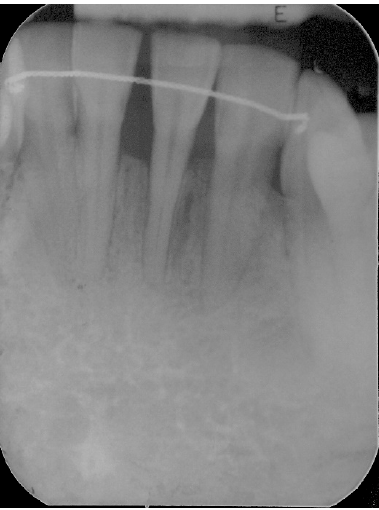
Figure 12. Two-year post-operative radiograph, stable results compared to the one-year situation are evident.